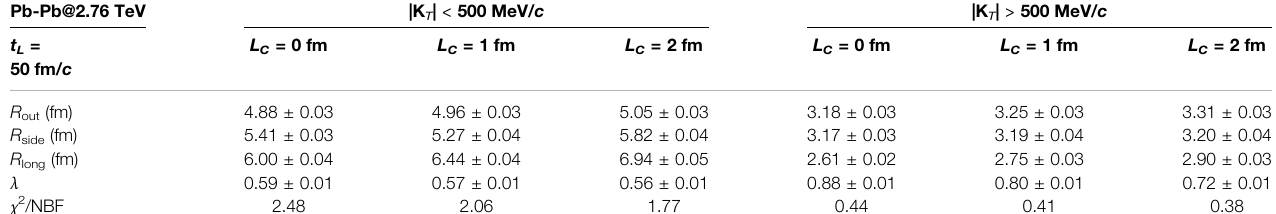
TABLE 2 | Fitted results of HBT radii and λ parameter in Eq. 9 for sources with L C = 0, 1, and 2 fm in central Pb-Pb collisions at ranges K T < 500 MeV/ c and K T > 500 MeV/ c . The t L value is 50 fm/ c , and ratios of χ 2 to the number of bins fi tted are also presented.